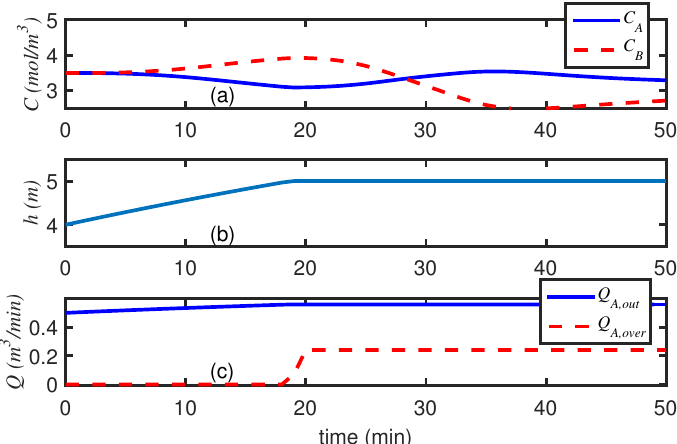
Figure 16. Results of the CSTR MPC problem showing other differential and algebraic state variables with time including the compositions of A and B ( a ); height of fluid in the surge tank ( b ); and flow from the surge tank ( c